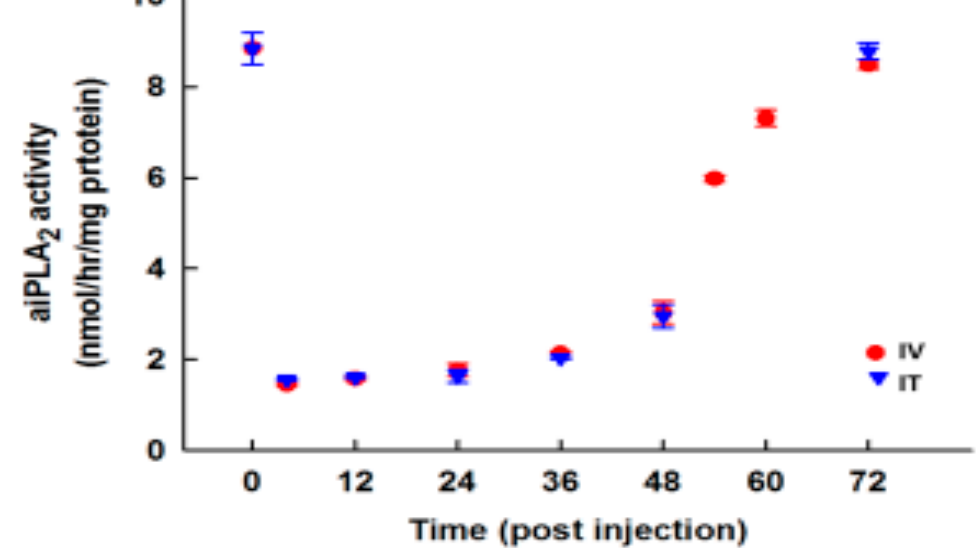
Figure 4. Persistence and stability of PIP-2 in vivo. PIP-2 was administered to mice either intratracheally (IT) or intravenously (IV) at 0 time. Lungs were harvested at intervals between 4 and 72 h after the PIP-2 administration, homogenized, and analyzed for aiPLA 2 activity. Results are mean + SEM for n = 3–4.